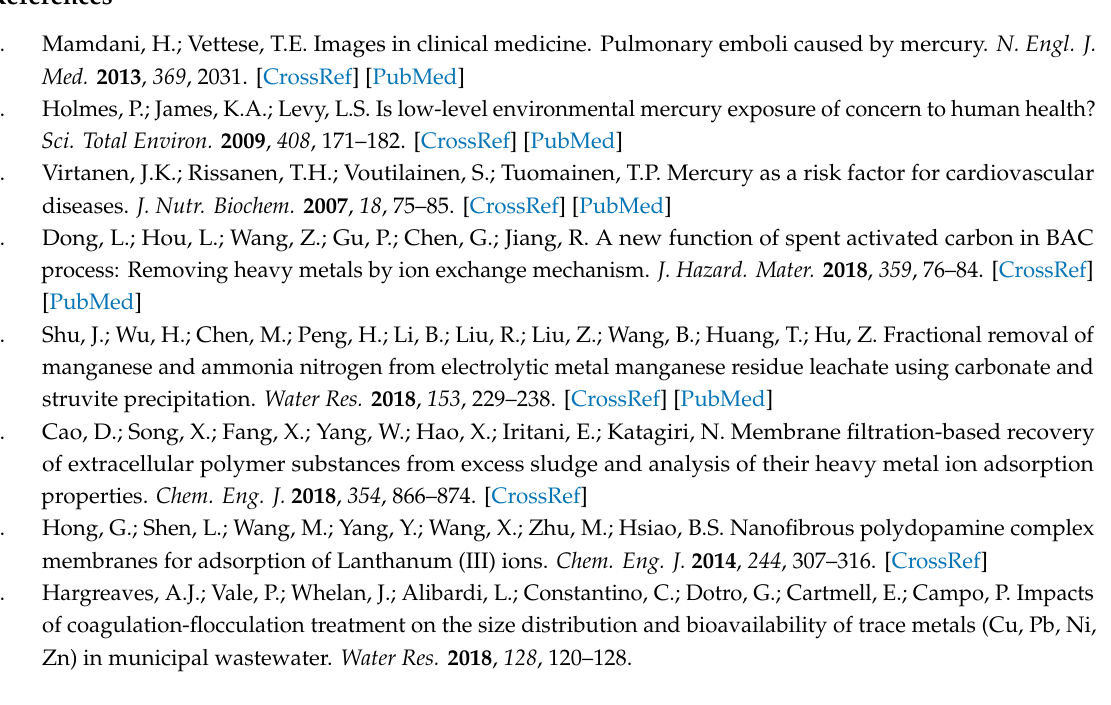
Figure S1: Hysteresis loop of OS / Fe3O4 /